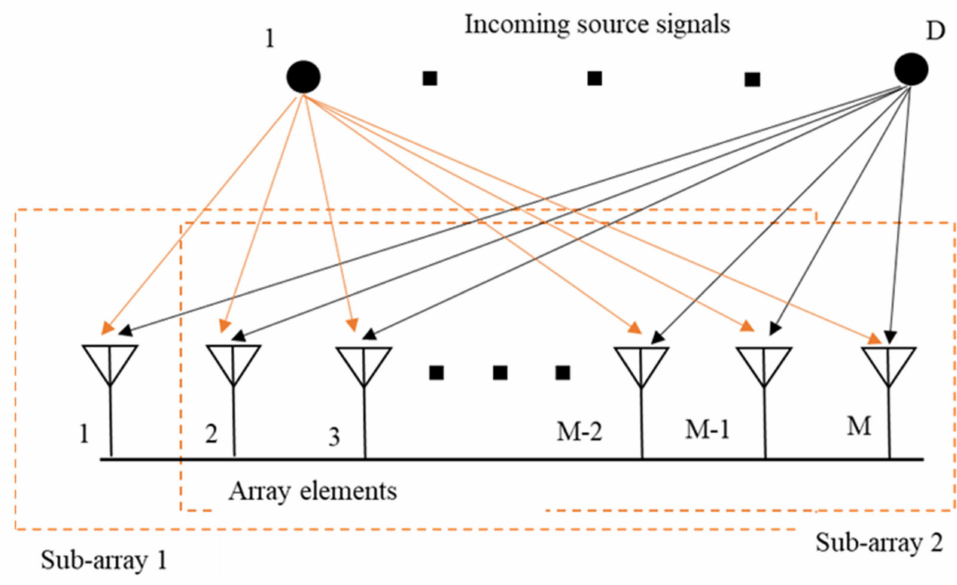
Figure 3. Multiple source DOA estimation using the ESPRIT